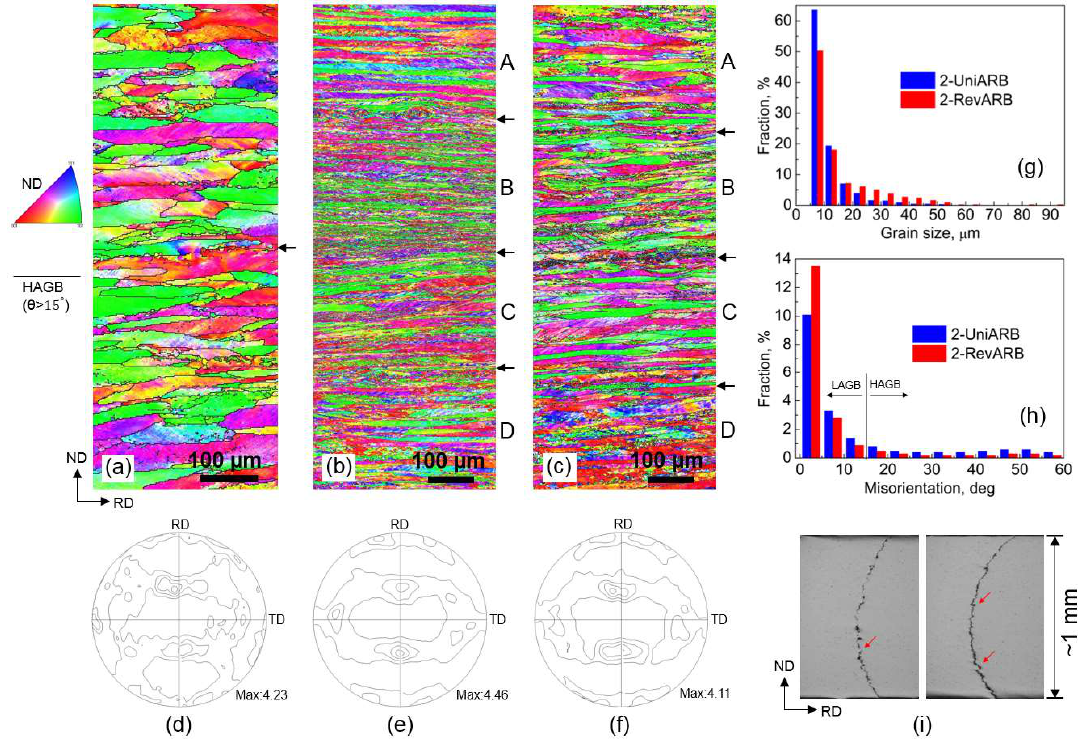
Figure 2. Through-thickness inverse pole figure (IPF), high angle grain boundaries (HAGBs) electron backscattered diffraction (EBSD) maps, and {111} pole figures after ( a,d ) 1-ARB, ( b,e ) 2-UniARB, and ( c,f ) 2-RevARB. ( g ) Distribution of grain size. ( h ) Misorientation angles after 2-UniARB and 2-RevARB. ( i ) An optical microscope (OM) image shows the flection of the deformed embedded-pin after 1-ARB.